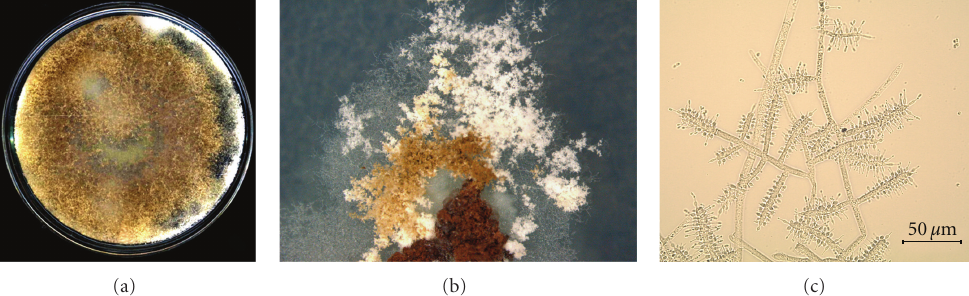
Figure 1: Escovopsis sp. parasites from fungus-growing ants. (a) General aspect of Escovopsis sp. isolated from the leaf-cutting ant Atta sexdens rubropilosa (Corumbata´ı, Brazil) cultured in potato dextrose agar (PDA) for 6 days at 25 ◦ C. (b) Close view of Escovopsis sp. isolated from Acromyrmex lobicornis (Santa F´e, Argentina) in PDA after 5 days at 25 ◦ C. (c) Escovopsis sp. conidiophores from (a). Note the cylindrical vesicles covered with ampulliform phialides.